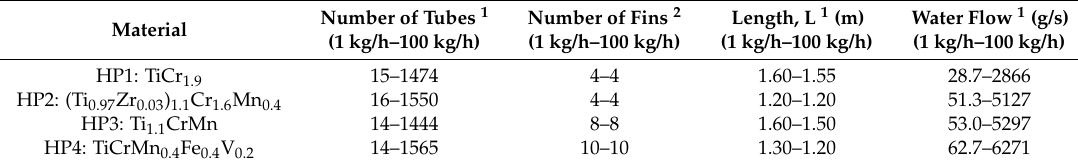
Table 4. Conceptual design results of the four downselected high-pressure metal hydrides (HP1, HP2, HP3, and HP4) processing 1 kg/h and 100 kg/h. Each system is comprised of four parallel